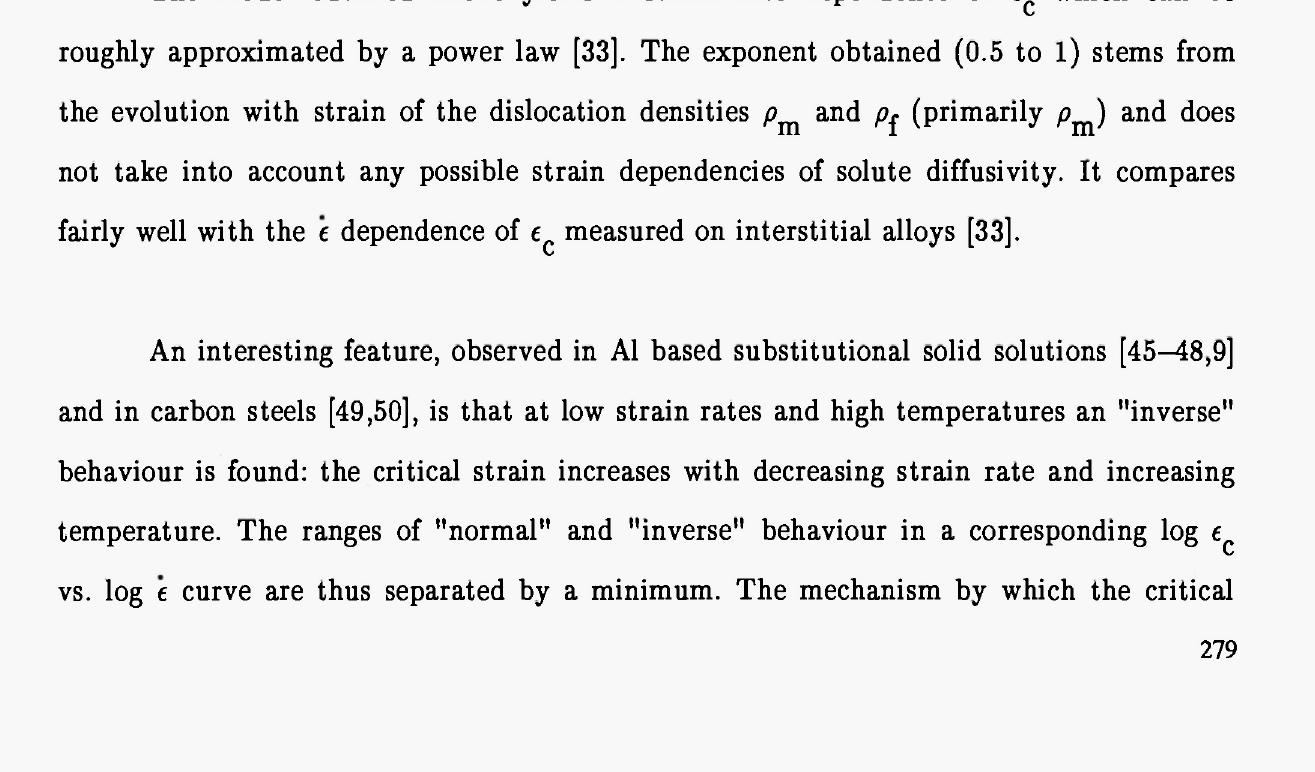
of deformation—induced vacancies whose concentration enters the diffusivity of substi- tutional solutes, but does not affect that of interstitial ones. There is no consensus on the origin of this difference among researchers, though, cf. Ref.